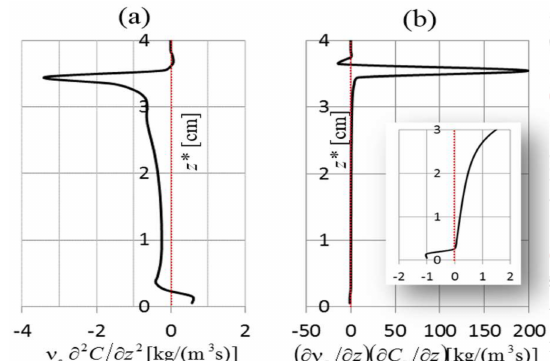
Figure 10. Main configuration with u a = 40 cm/s and C * = 180 g/L. Shown are the equilibrium profiles of the two terms on the right-hand side of (29), making up the vertical sediment diffusion term in (7). The insert in ( b ) shows details for the lower 3 cm of the water column for comparison with ( a ).